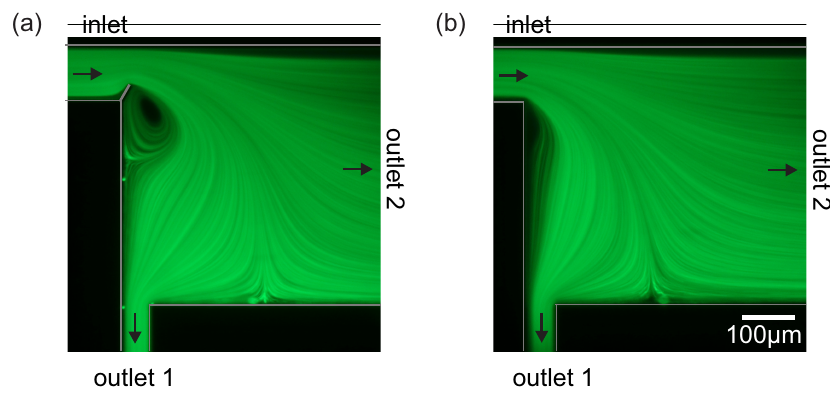
Figure 4. Micrographs of fluorescent particle streamlines in the optimized sudden expansion channel with ( a ) and without ( b ) corner structure at Re = 25.